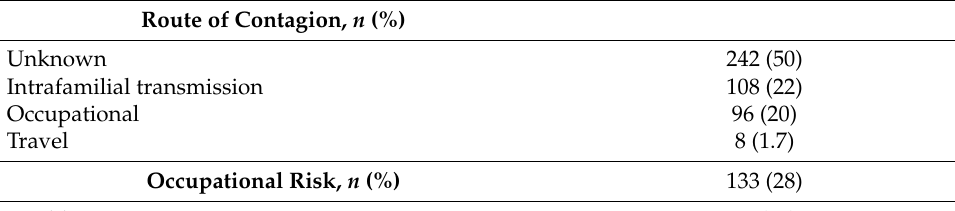
Table 3. Epidemiological factors of SARS-CoV-2 infection and occupational risk. Route of Contagion, n (%)